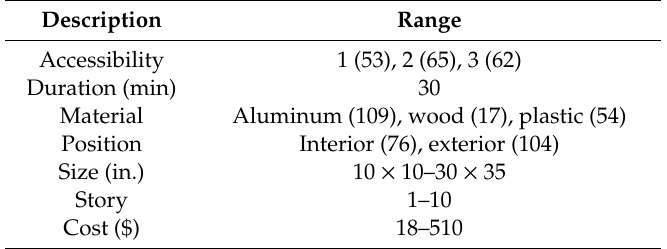
Table 2. Overview of the 180 windows for the case-based reasoning (CBR)